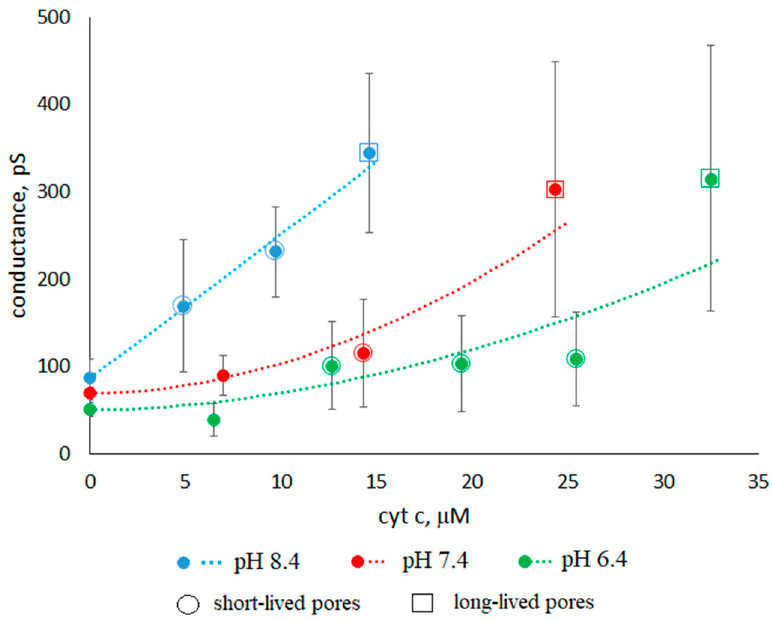
Figure 5. Dependence of the conductance of asolectin membranes on the cyt c concentration C . Cyt c additive is symmetrical, 0.1 M KCl. The approximating curves (dotted lines) show an increase in conductance with the addition of cyt c: 0.3 C 1.8 at pH 6.4, 0.4 C 1.9 at pH 7.4, and 16 C 1.0 at pH 8.4. Circles and squares show the appearance of short-lived and long-lived pores, respectively. Standard errors are shown.